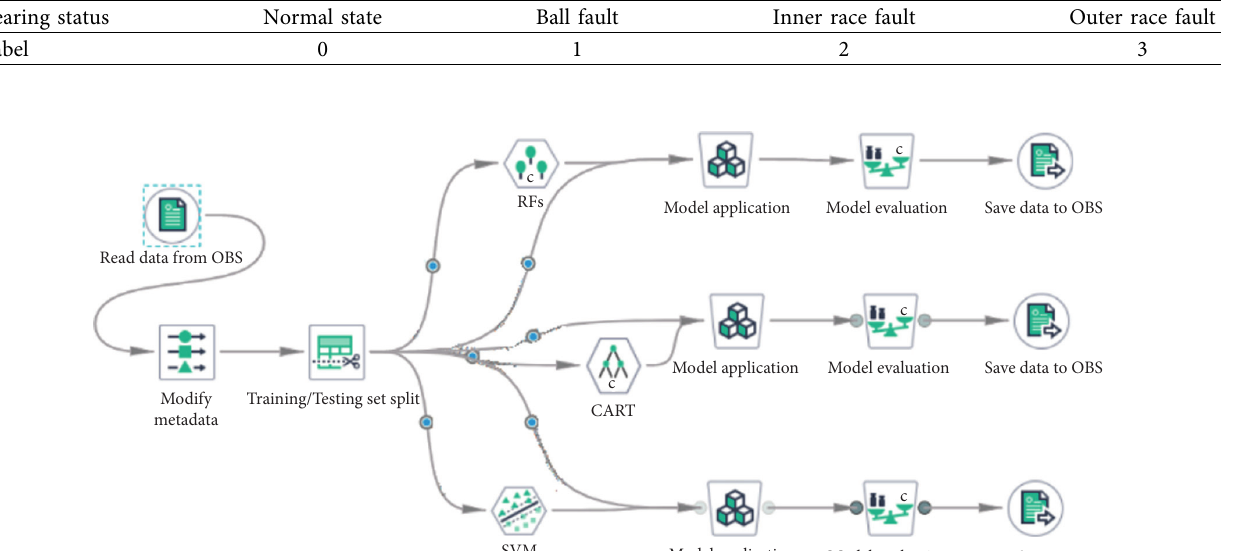
Figure 4: Model comparison and simulation analysis.